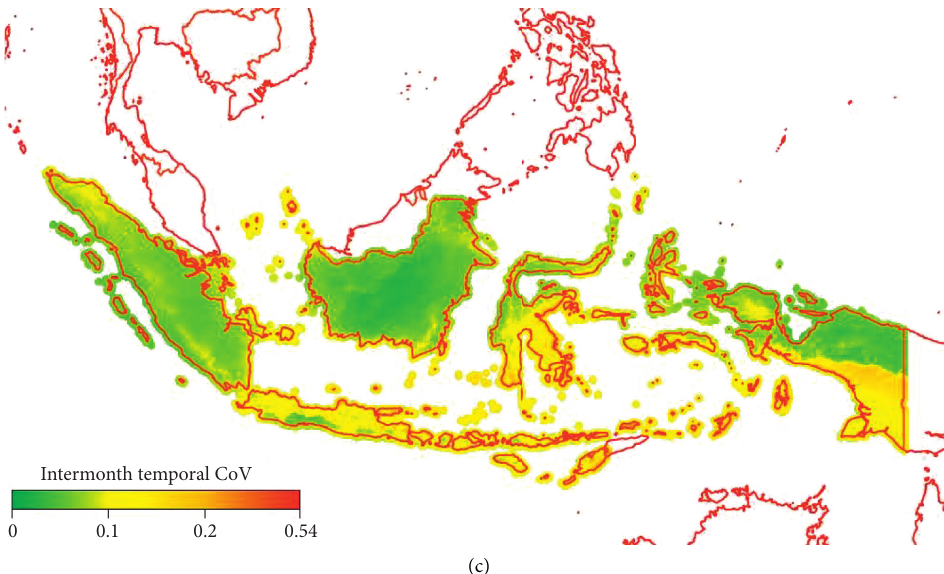
Figure 3: CoV T on the 1999–2016 period. (a) CLARA-A2. (b) POWER. (c) SolarGIS.